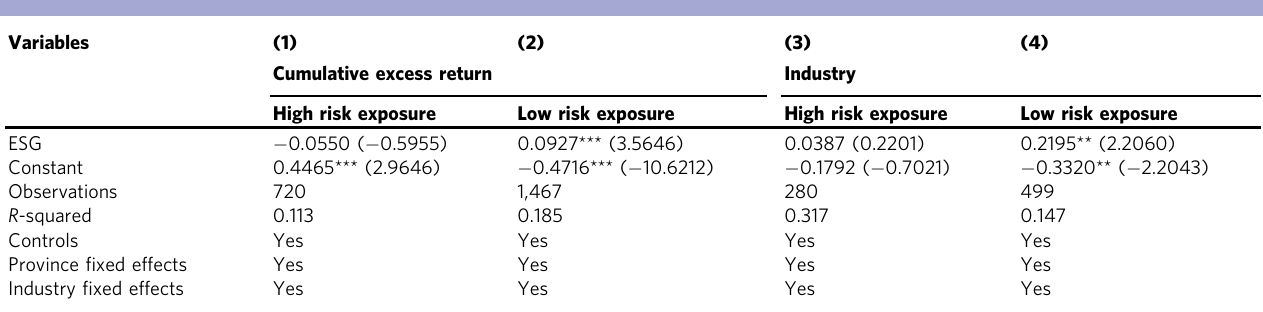
Table 4 Risk exposure test